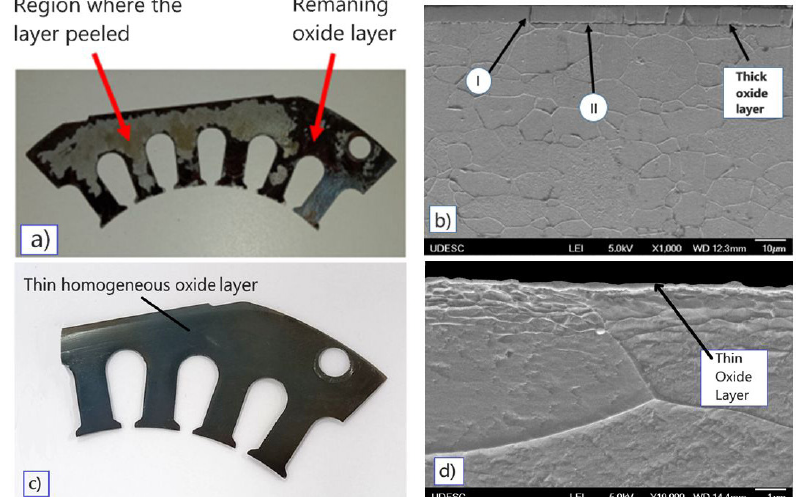
Figure 2. Samples treated under unfavorable condition for generation of homogeneous, thick, and adherent oxide layers. Sample (O500- 2h) treated at 500°C for 2,0h: a) detached layer region; b) cross section micrography showing spalling and de-cohesion at interface layer- core. Sample (O300-0,5h) treated at 300°C for 0,5h: c) homogeneous surface after oxidation; d) cross section indicating non-formation of a well-defined oxide layer.